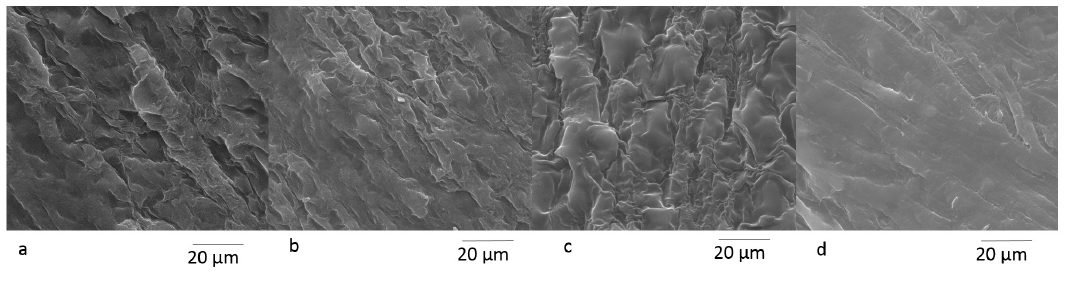
Figure 7. SEM images of the control film (a), the RH-film (b), the RHB-film (c) and the RHNF-films (d).